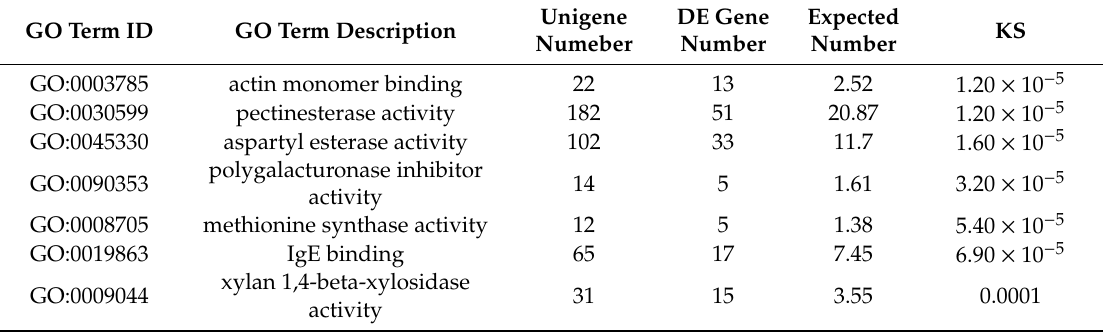
The “Unigene number” line, “DE Gene Number” line, “Expected Number” line, and “KS” line display the number of unigenes, number of di ff erentially expressed genes, expected number annotated to the related corresponding GO term, and the p -value of the KS test, respectively. Table 5. Top 10 GO terms in the CC category of di ff erentially expressed genes in Bcpol97-05A (sterile line) compared to Bcajh97-01B (fertile line) of Brassica campestris